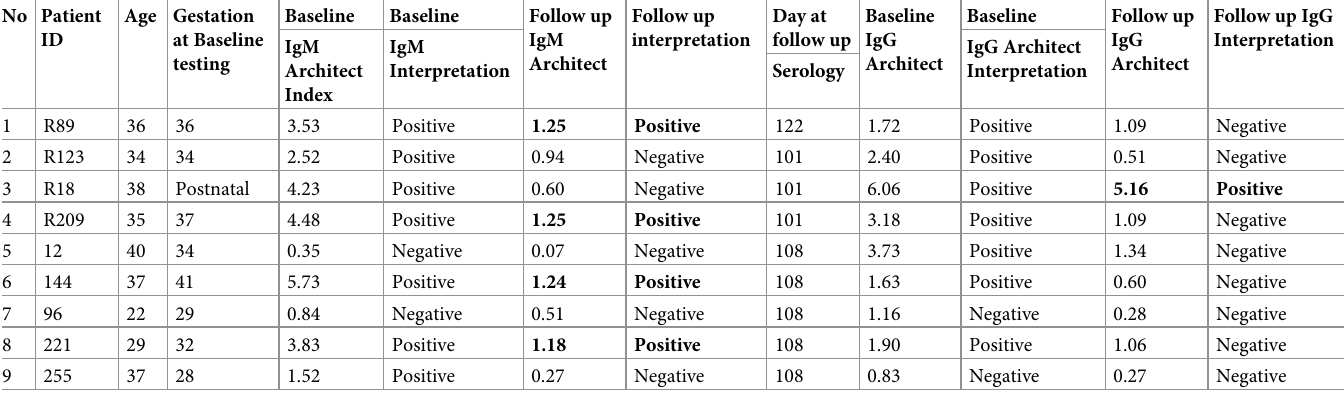
Table 1. Follow up serology IgM and IgG (asymptomatic